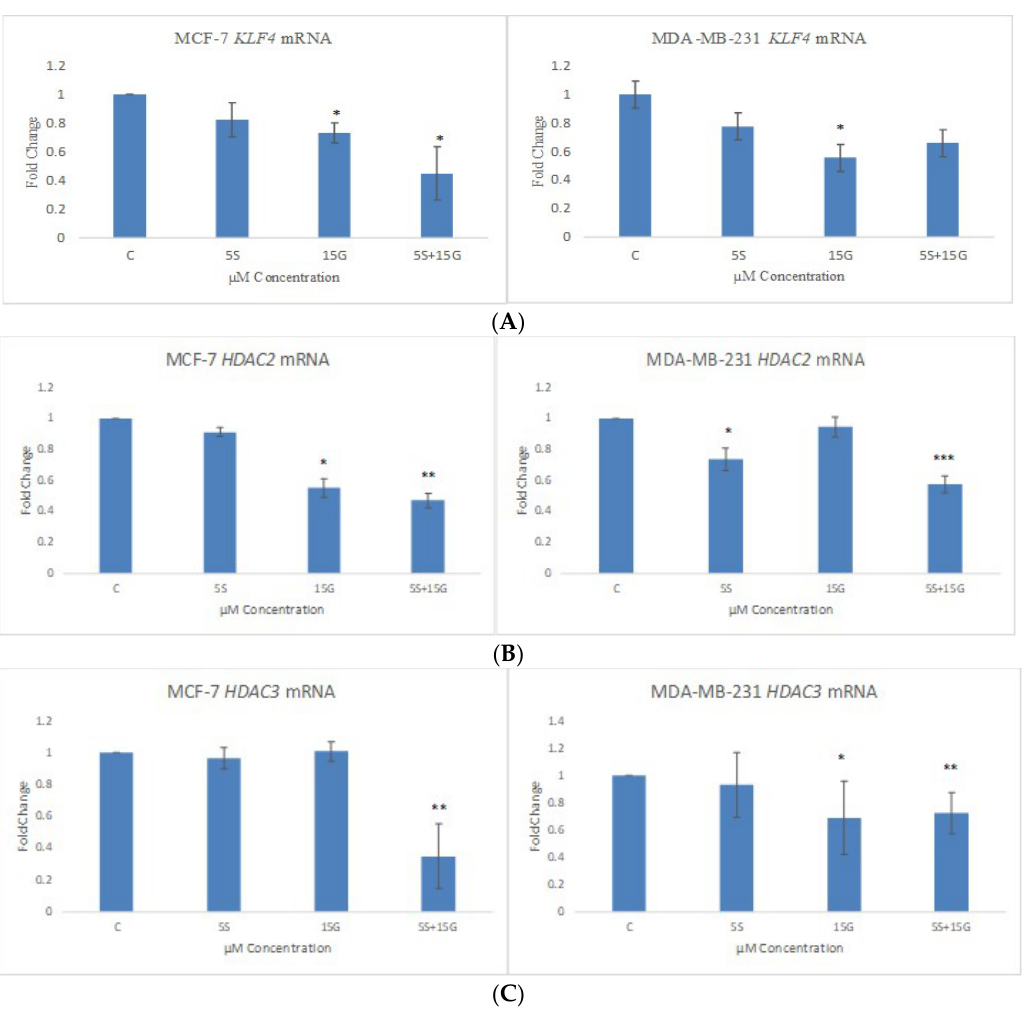
Figure 8. RT-PCR. KLF4 , HDAC2 and HDAC3 mRNA levels are downregulated by the combinatorial treatment in both cell lines. Combinatorial GEN and SFN downregulate KLF4 , HDAC2 and HDAC3 mRNA expression. qRT-PCR was performed to determine the mRNA expression. ( A ) KLF4 mRNA expression is shown in MCF-7 and MDA-MB-231cells; ( B ) HDAC2 mRNA expression is shown in MCF-7 and MDA-MB-231 cells; ( C ) HDAC3 mRNA expression is shown in MCF-7 and MDA-MB-231 cells. The results represent the average of three separately cultured experimental replicates. (* p < 0.05, ** p < 0.01, *** p < 0.001).